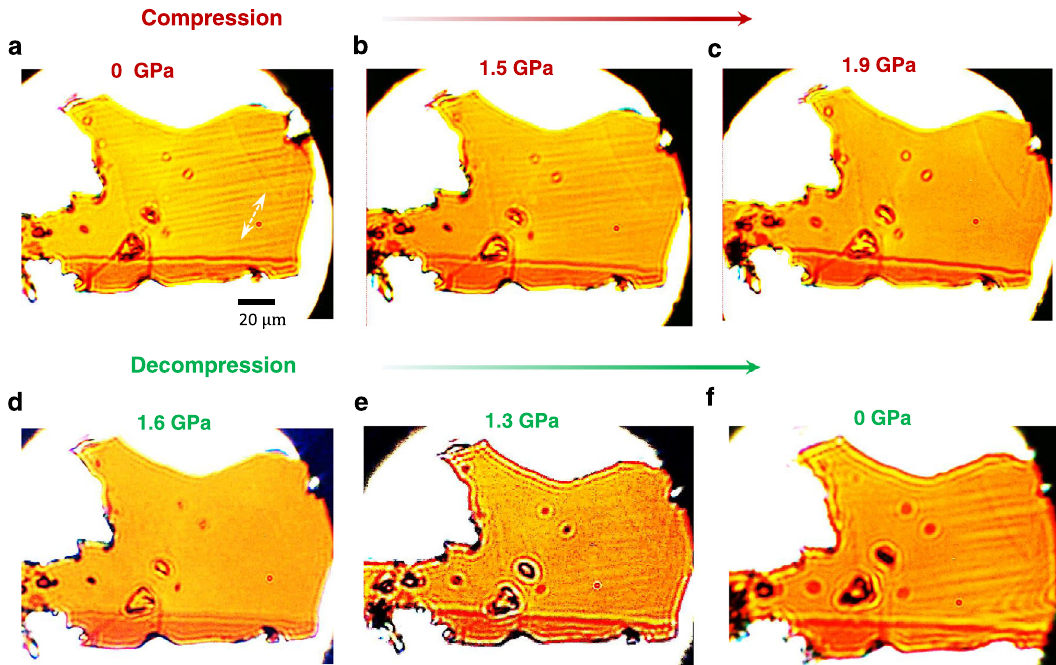
double-arrow symbol (white color) indicates the direction of linear polarization. d – f Recovery of the domain contrast upon releasing the pressure.